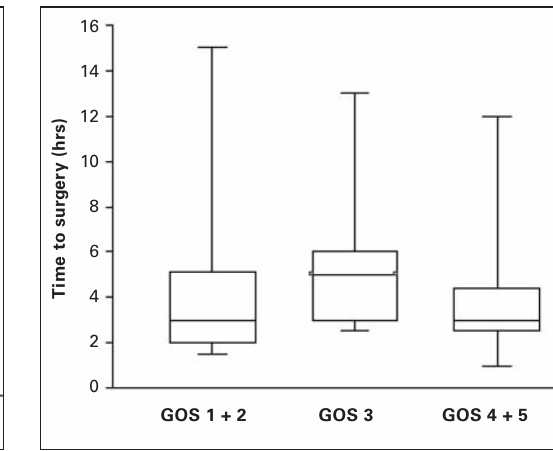
Impact of time to surgery on final outcome showing almost identical distribution of time to surgery for all outcomes (favourable and unfavourable). Abbreviations: GOS: Glasgow Outcome Scale (1: death; 2: persistent vegetative state; 3: severe disability; 4: moderate disability; 5: good recovery).